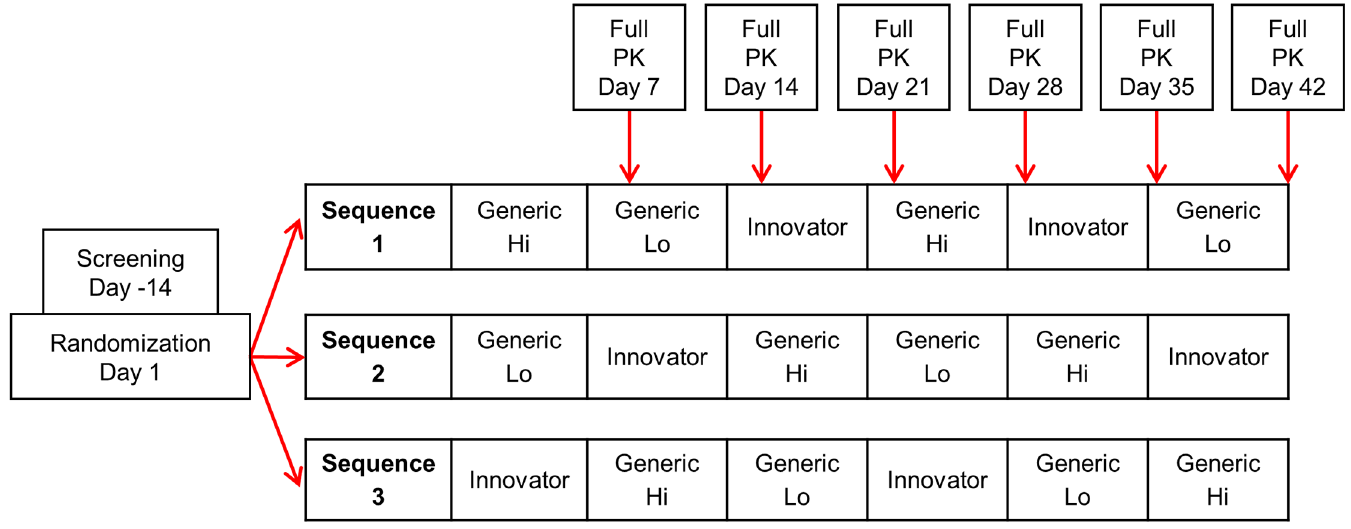
Fig 1. Randomization sequence and study design. PK, pharmacokinetics.